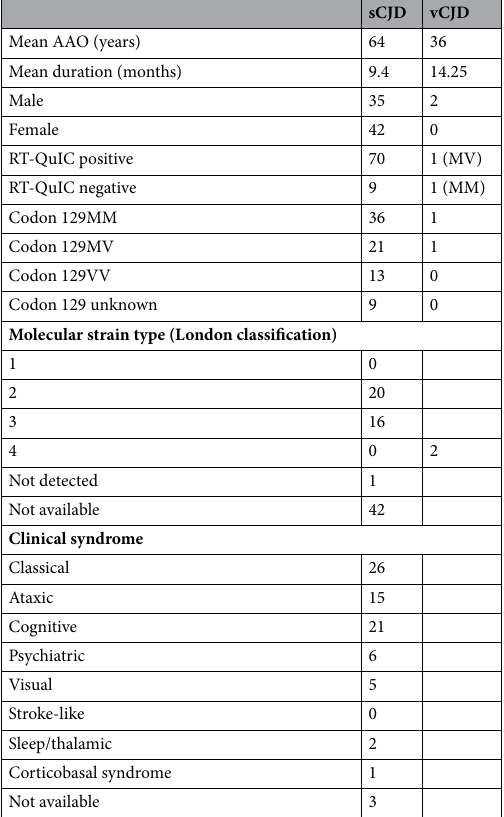
Table 1. Summary of patient demographics, PRNP codon 129 and molecular strain type where available. This table summarises the relevant demographics from sporadic (sCJD) and variant CJD (vCJD) patients from whom CSF samples were obtained at post mortem which were included in the RT-QuIC assays. This covers mean age at onset (AAO), duration of illness in months, gender, RT-QuIC results, PRNP codon 129 genotype (some untested), molecular strain type (London Classification 48 ) and clinical